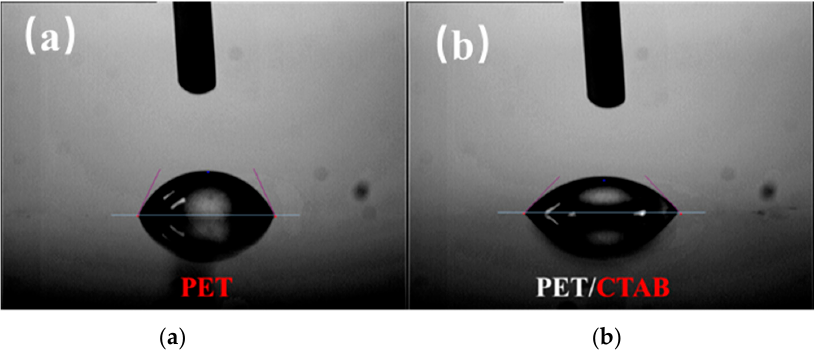
Figure 6. Contact angle of the surface of ( a ) neat PET and ( b ) PET/CTAB.